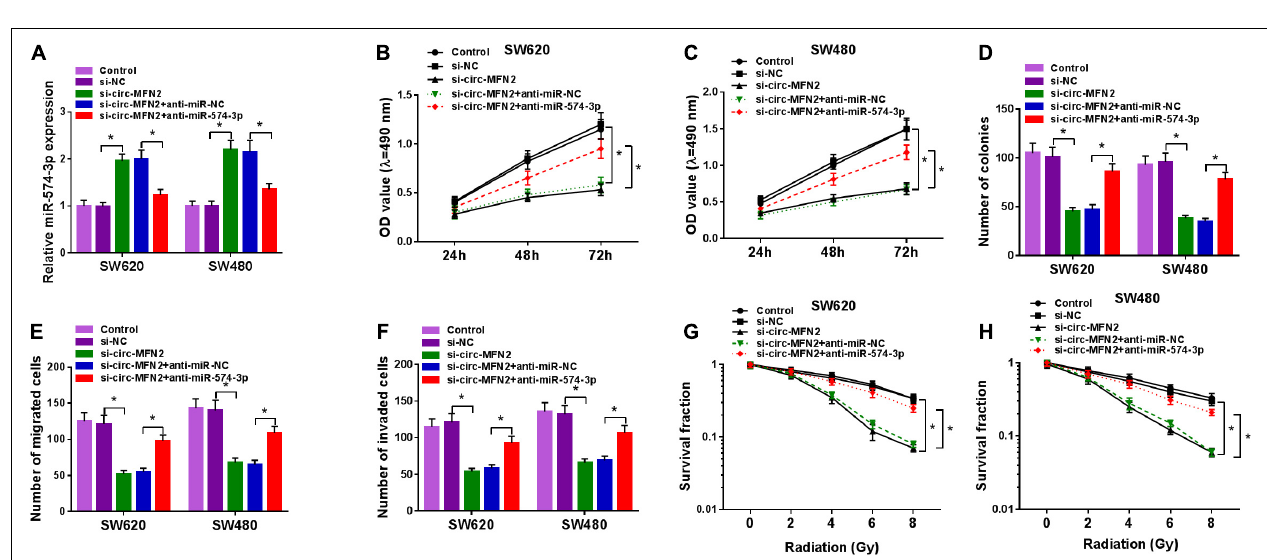
FIGURE 5 | The regulation of circ-MFN2 silencing and miR-574-3p inhibitor on CRC progression. SW620 and SW480 cells were transfected with si-NC, si-circ-MFN2, si-circ-MFN2 + anti-miR-NC or si-circ-MFN2 + anti-miR-574-3p, and non-transfected cells were used as control. (A) The expression of miR-574-3p was measured by qRT-PCR to evaluate transfection efficiency. (B,C) The viability of cells was detected using MTT assay. (D) The number of colonies was assessed using colony formation assay. (E,F) The migration and invasion of cells were examined by transwell assay. (G,H) Colony formation assay was performed to detect the survival fraction of cells. * P <